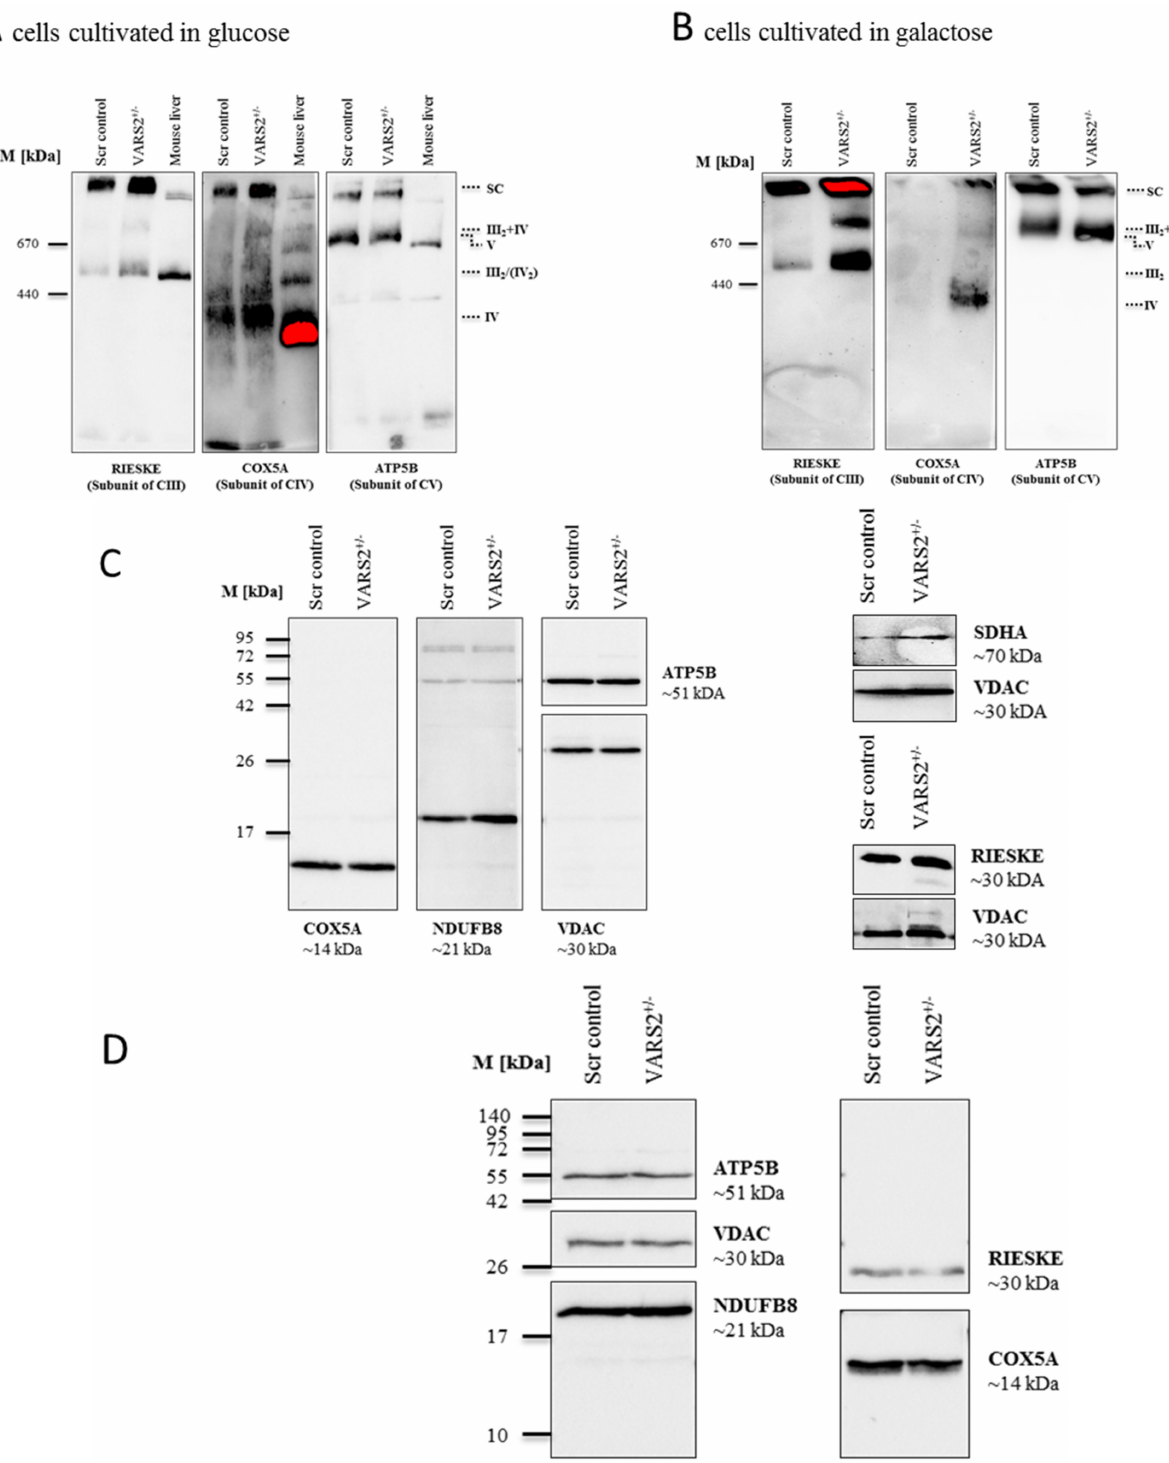
Figure 3. BN-PAGE analysis of respiratory chain supercomplex in mitochondria isolated from cells grown in glucose ( A ) or galactose ( B ). Western blot analysis of denatured respiratory subunits in mitochondria isolated from cells cultivated in glucose ( C ) or galactose ( n = 1) ( D ). Mouse liver was run as a positive